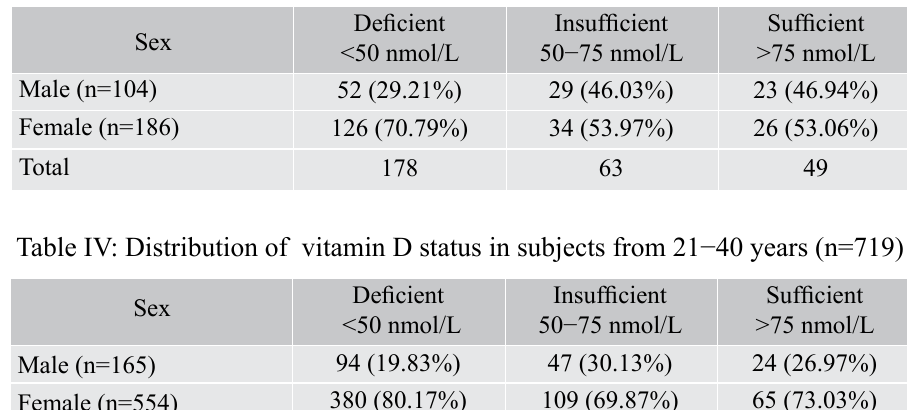
Table III: Distribution of study population according to vitamin D status in